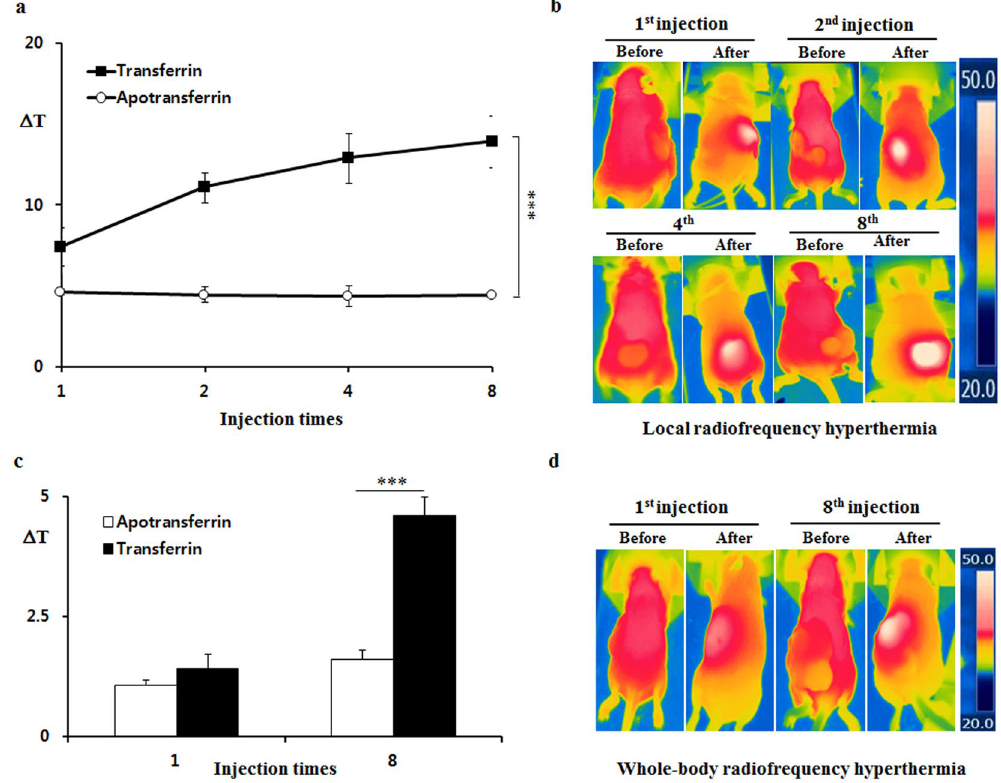
Figure 3. The cancer tissues became more reactive to 13.56 MHz radiofrequency hyperthermia as i . v . injections of transferrin were repeated. ( a ) The repeated i . v . injections of transferrin to tumor-bearing mice boosted temperature elevation in a local 13.56 MHz radiofrequency hyperthermia as ferric ion accumulated (see Supplementary Fig. 2). ( b ) The representative images of (a). ( c ) The repeated i . v . injection of transferrin boosted temperature elevation in a whole-body 13.56 MHz radiofrequency hyperthermia as ferric ion accumulation increased. ( d ) The representative images of (c). The temperature was measured before and